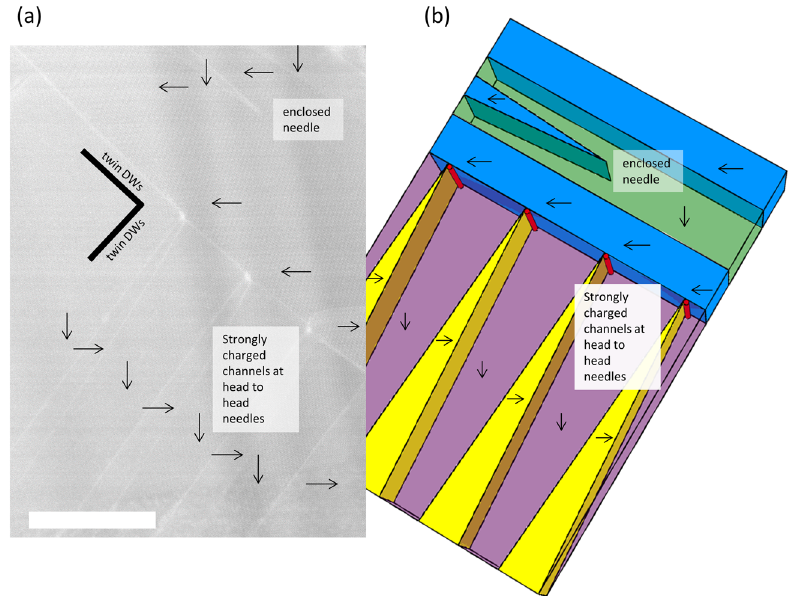
Fig. 6 Overview of the domain structure that causes charged needle points. a Lower magni fi cation scanning transmission electron microscopy image showing the wider domain structure with both an enclosed needle (top) and an array of charged needle points. b 3D model of the domain con fi guration in ( a ) leading to charged nanochannels at the charged needle points. The model is tilted with respect to the real viewing direction to show the 3D structure. Scale bar = 100